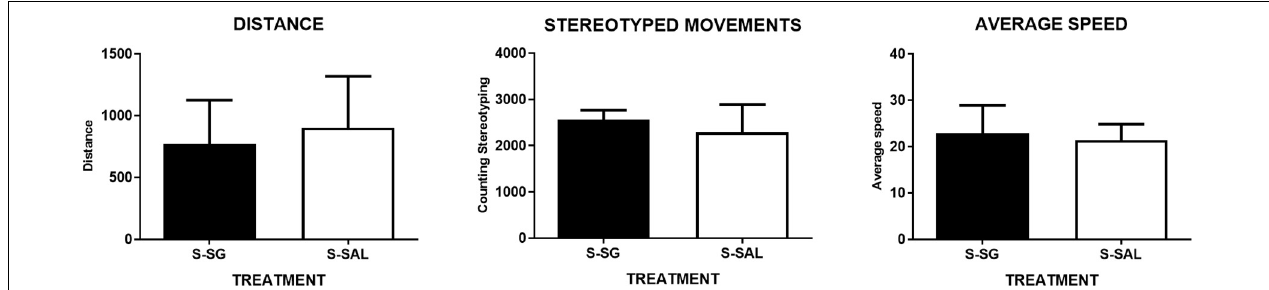
FIGURE 5 | Post-surgical motor activation assessment. Motor activity graphs. No differences between both surgery groups treated with sugammadex (S-SG; n = 5) or saline (S-SAL; n = 6) were detected. The data were analyzed by Student t -test for distance, ( left graph) (means ± SEM: 906.3 ± 170.4 (S-SAL); 773 ± 157.4 (S-SG); p = 0.595), stereotypic movements ( middle graph) (2291 ± 243.6 (S-SAL); 2,560 ± 93.68 (S-SG); p = 0.366), and mean speed, ( right graph) (means: 21.43 ± 1.398 (S-SAL), 22.8 ± 2.712 (S-SG), p = 0.647).